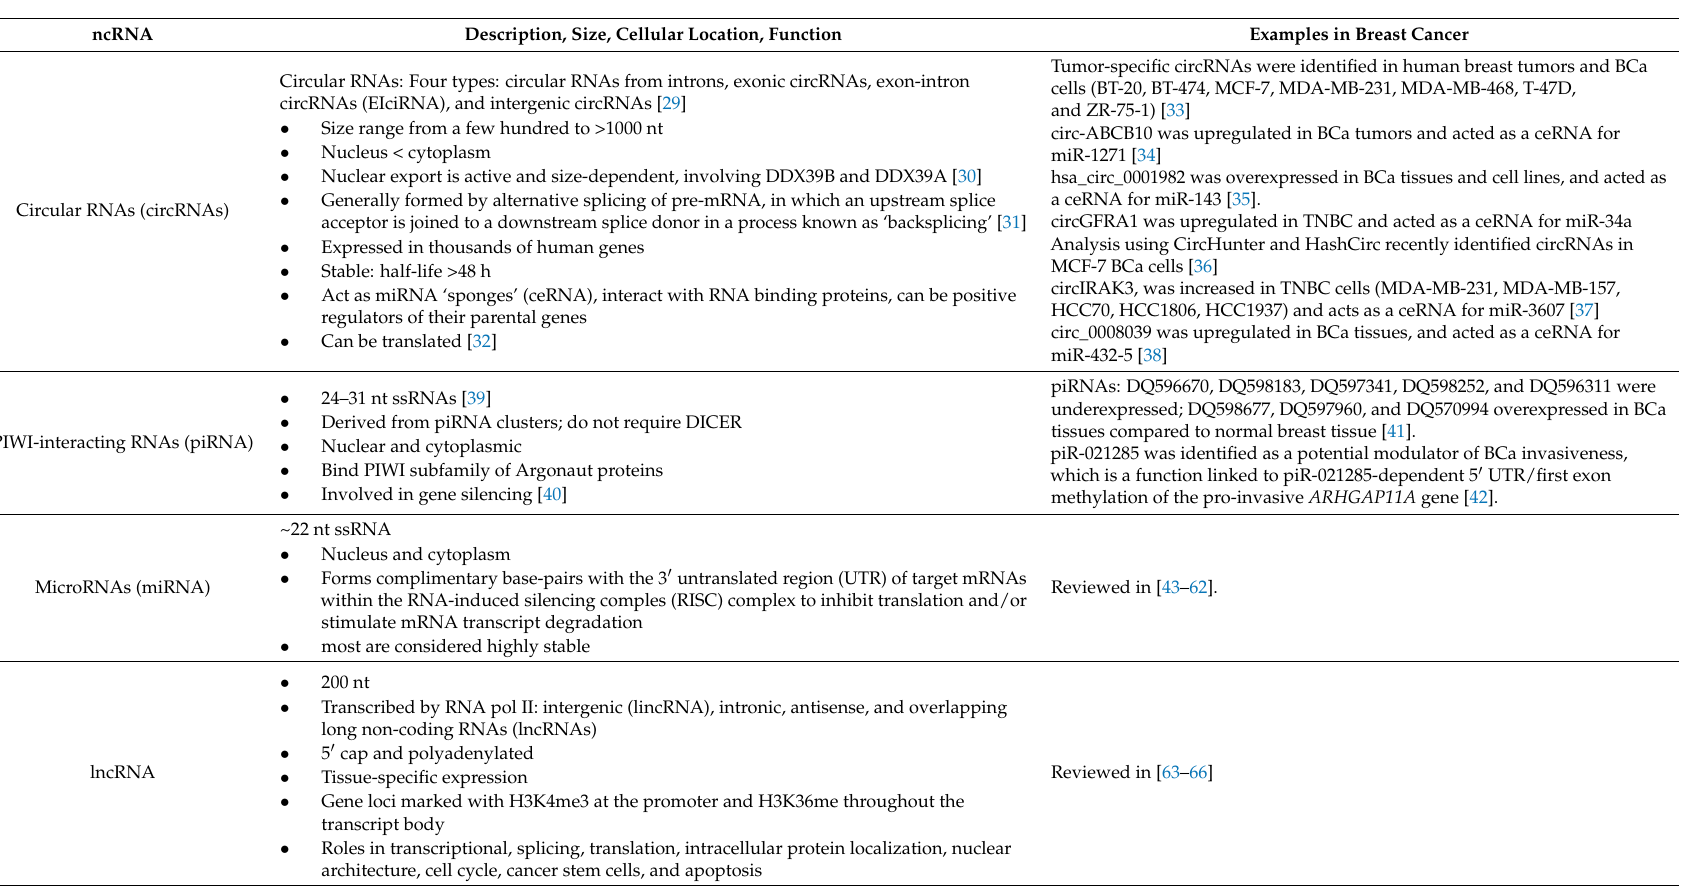
Table 1. Regulatory non-coding RNAs (ncRNAs) in breast cancer. Abbreviations: BCa (breast cancer), ceRNA: competing endogenous RNA; TNBC: triple negative breast cancer, ssRNA: single-stranded